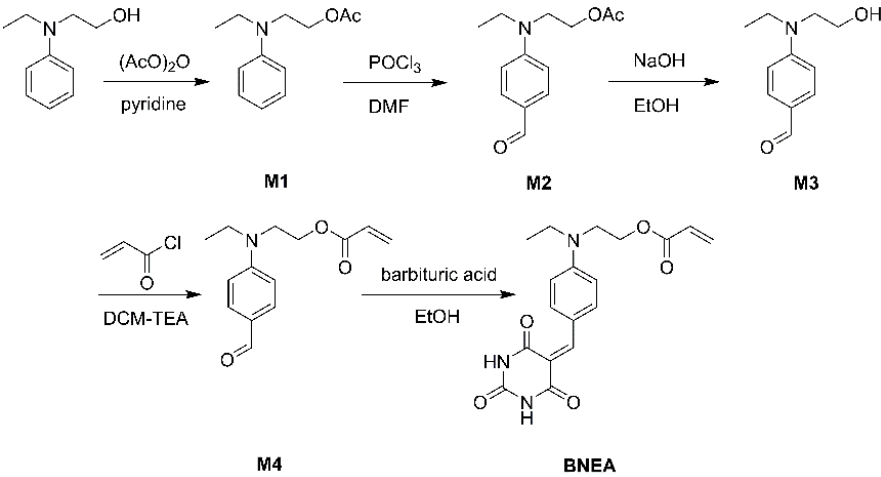
Scheme 2. Synthetic procedures for BNEA.